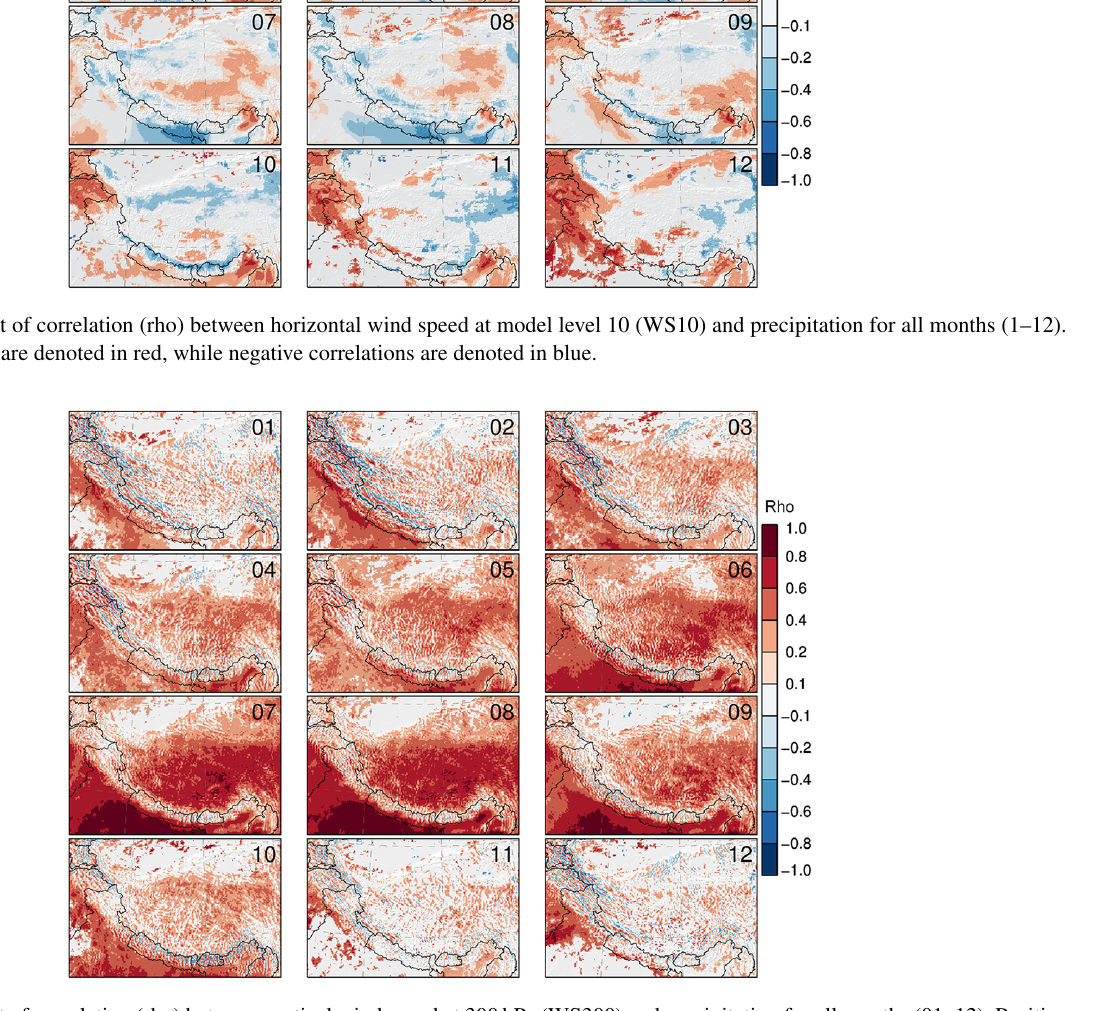
Figure 5. Coefficient of correlation (rho) between vertical wind speed at 300hPa (WS300) and precipitation for all months (01–12). Positive correlations are denoted in red, while negative correlations are denoted in